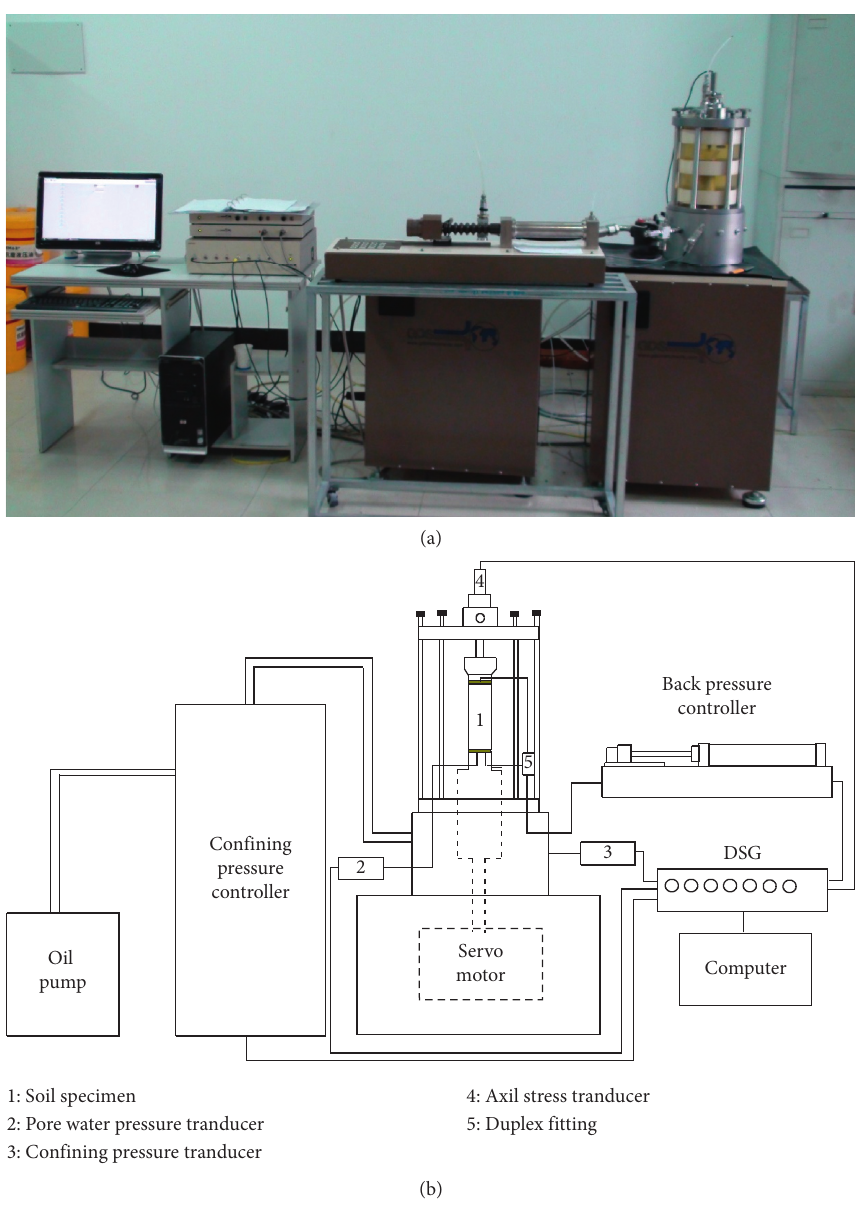
Figure 2: (a) General view of the apparatus. (b) Schematic diagram of advanced cyclic triaxial device.